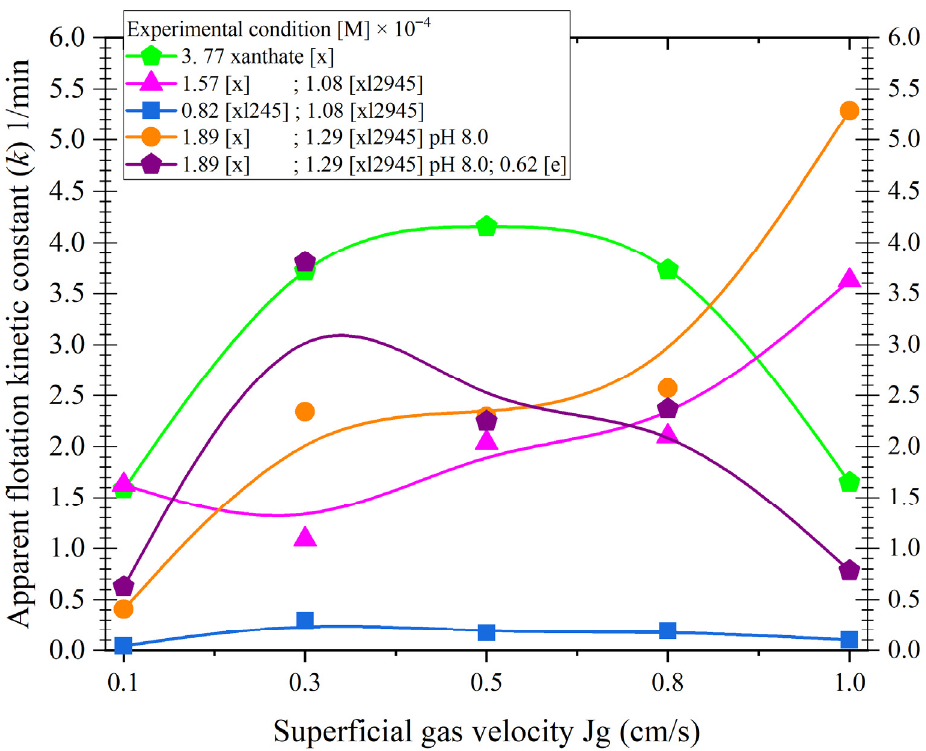
Figure 20. Apparent flotation kinetic constant (K) 1/min as function of superficial gas velocity. For di ff erent experimental conditions.